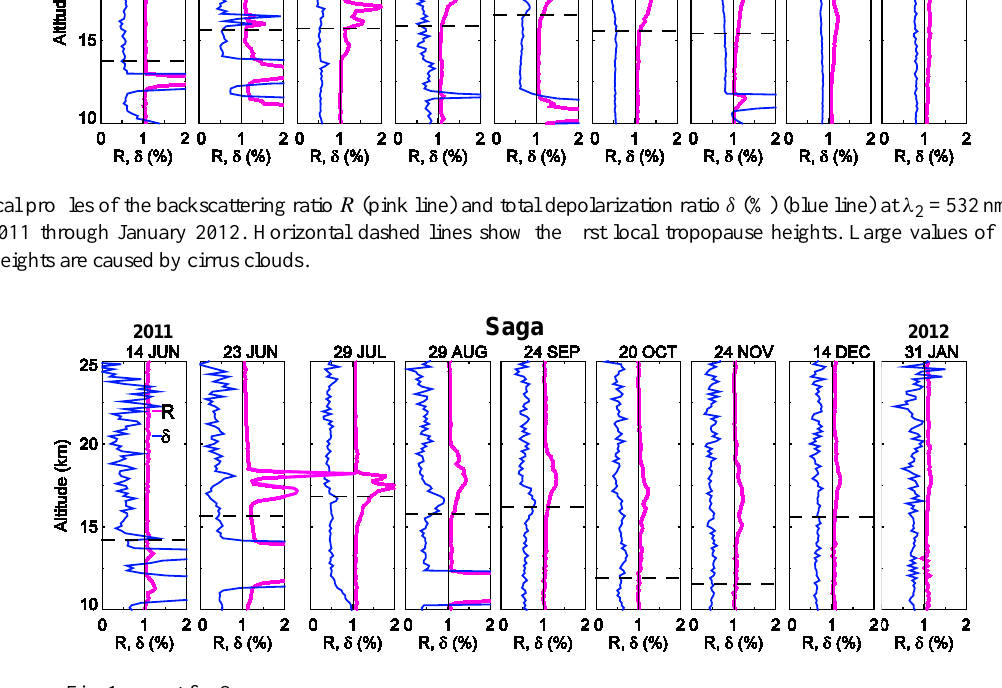
Fig. 2. The same as Fig. 1 except for